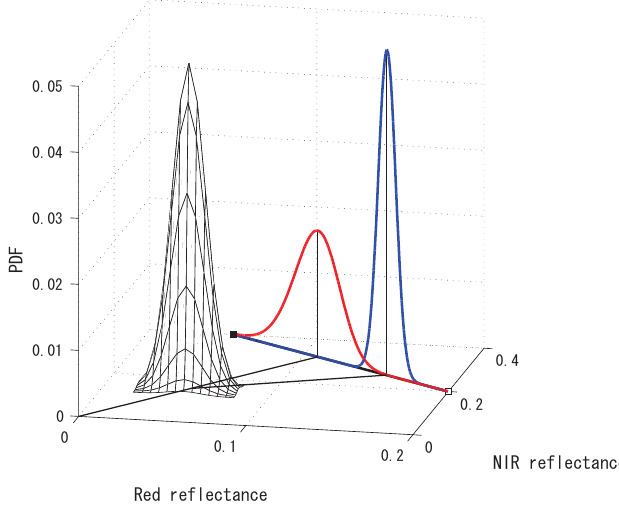
Figure 1 . Two-parameter normal distribution of the input noise centered on a target spectrum, and FVC distributions estimated using two algorithms. The two-dimensional distribution is projected onto the modeled subspace spanned by the two endmember spectra in the red–NIR reflectance space. The FVC distributions estimated using each algorithm are denoted by red and blue lines, along with the line between the two endmember